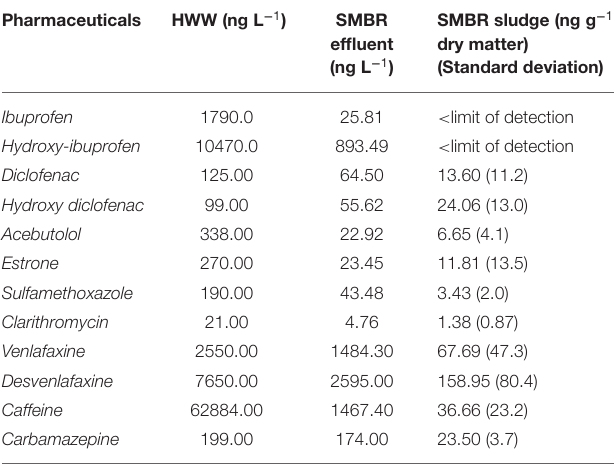
TABLE 1 | Mean concentration of pharmaceuticals in SMBR influent, effluent, and sludge at optimized treatment condition.